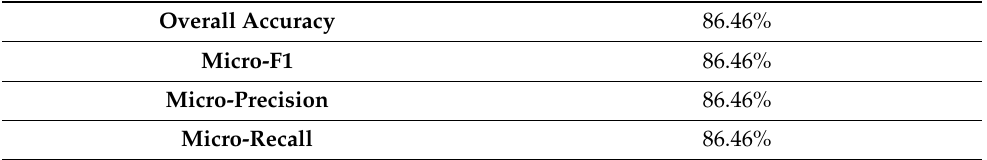
Table 10. The overall accuracy of the land suitability model in Java Island using SVM.